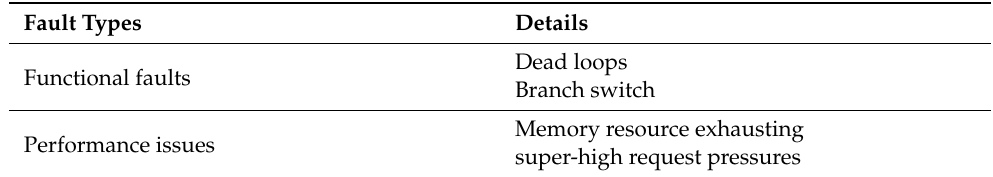
Table 1. The fault types injected into Cassandra.